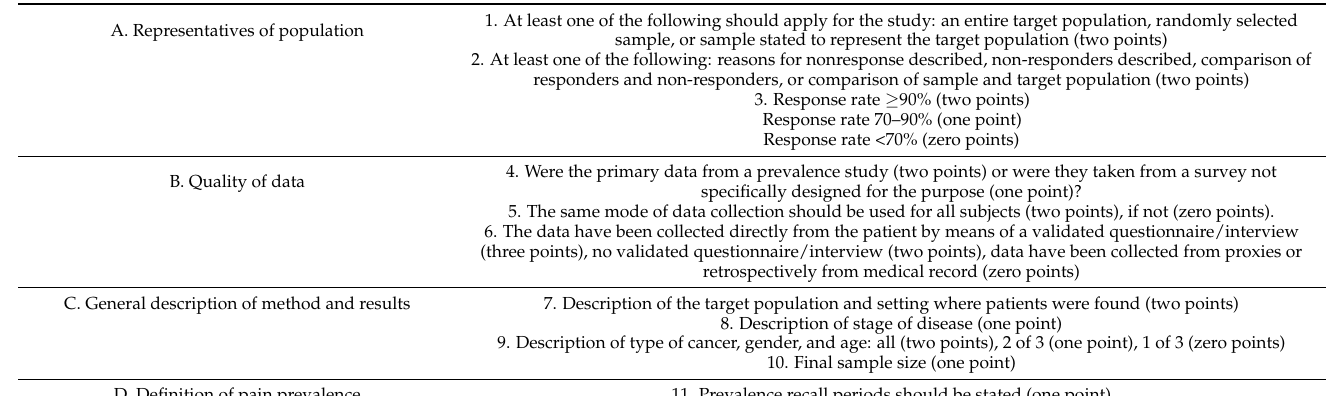
Table 1. Methodological quality criteria for prevalence